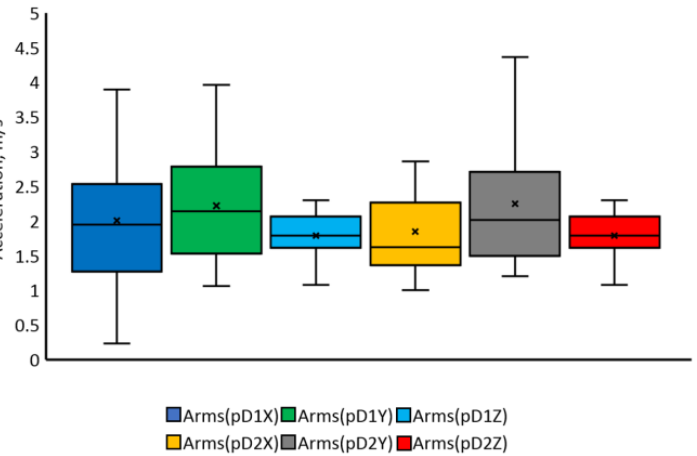
Figure 16. Summary of rms acceleration values obtained in the study of reaching movements in the deceleration phase.